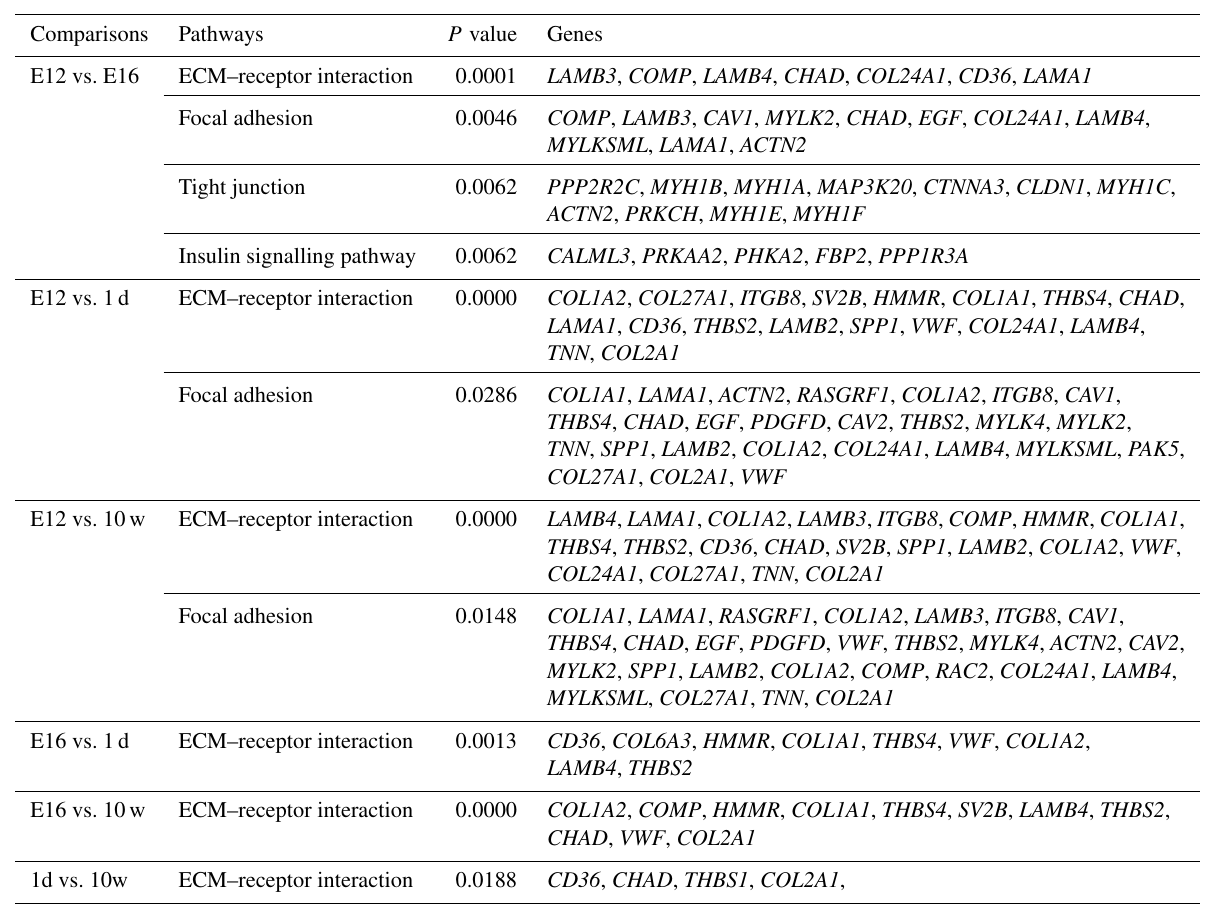
Table 5. Pathways related to muscle growth and development.